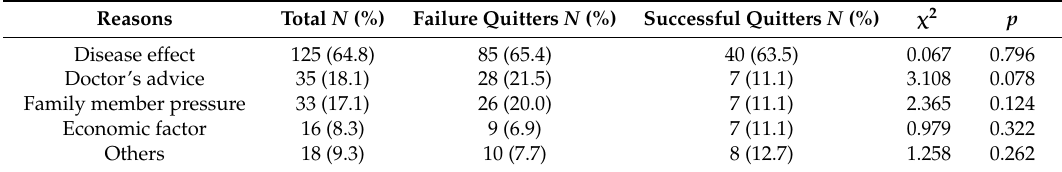
Table 3. Reasons for trying to quit smoking among failed and successful